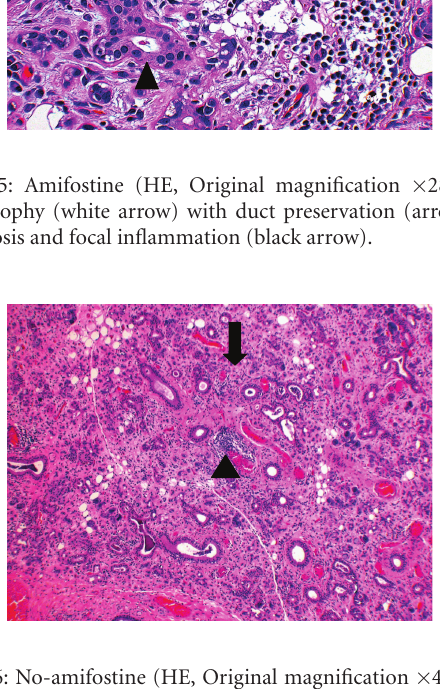
Figure 4: No-amifostine (HE, Original magnification × 28). Sub- mandibular gland of no-amifostine patient shows lobular remnants and residual ducts with vacuolar degeneration. Ducts are surround- ed by lymphoplasmacytic infiltrate and mild fibrosis.